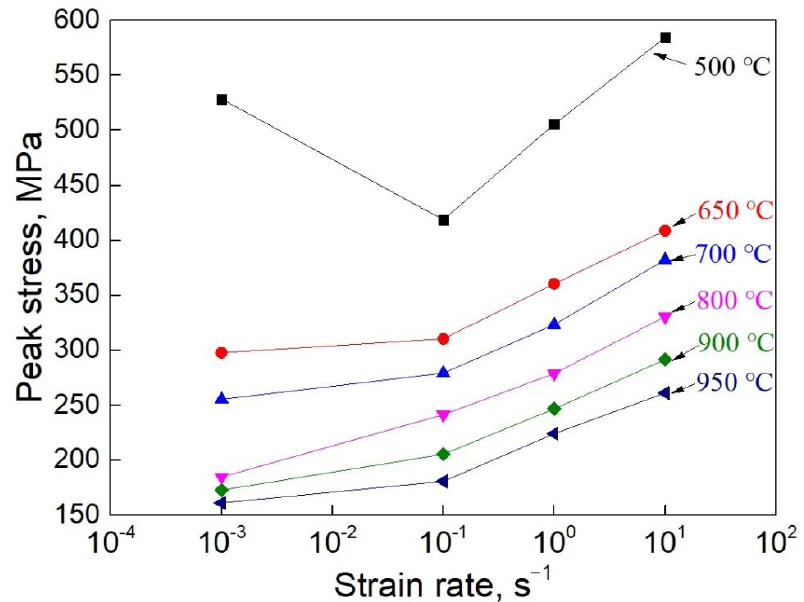
Figure 4. The relationship between strain rate and peak stress of the studied steel at various deformation temperatures.